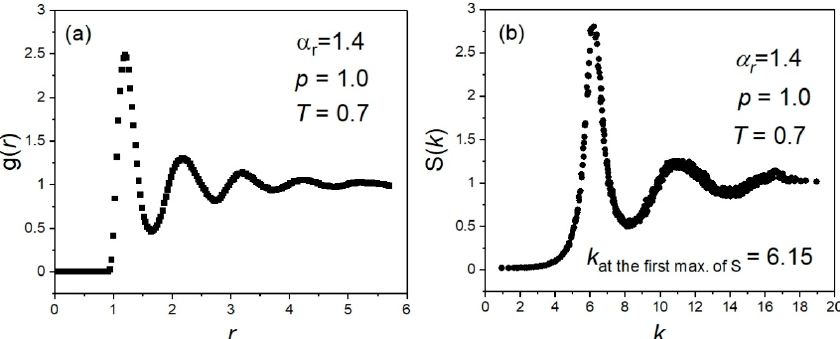
Figure 10. Presentation of ( a ) the radial distribution function plotted vs. the distance r and ( b ) the static structure factor plotted vs. the length of the wave vector k , selected as examples for the system of molecules of the aspect ratio α r = 1.4, simulated in the GB model in the NPT ensemble at the pressure p = 1.0 and the temperature T = 0.7.